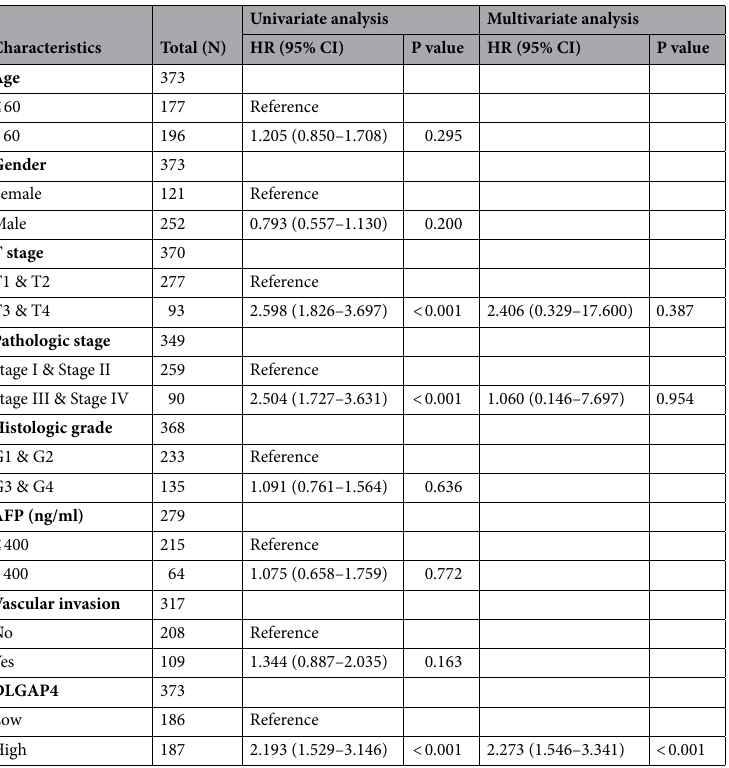
Table 2. Univariate and multivariate Cox regression analyses of the clinical characteristics associated with OS in